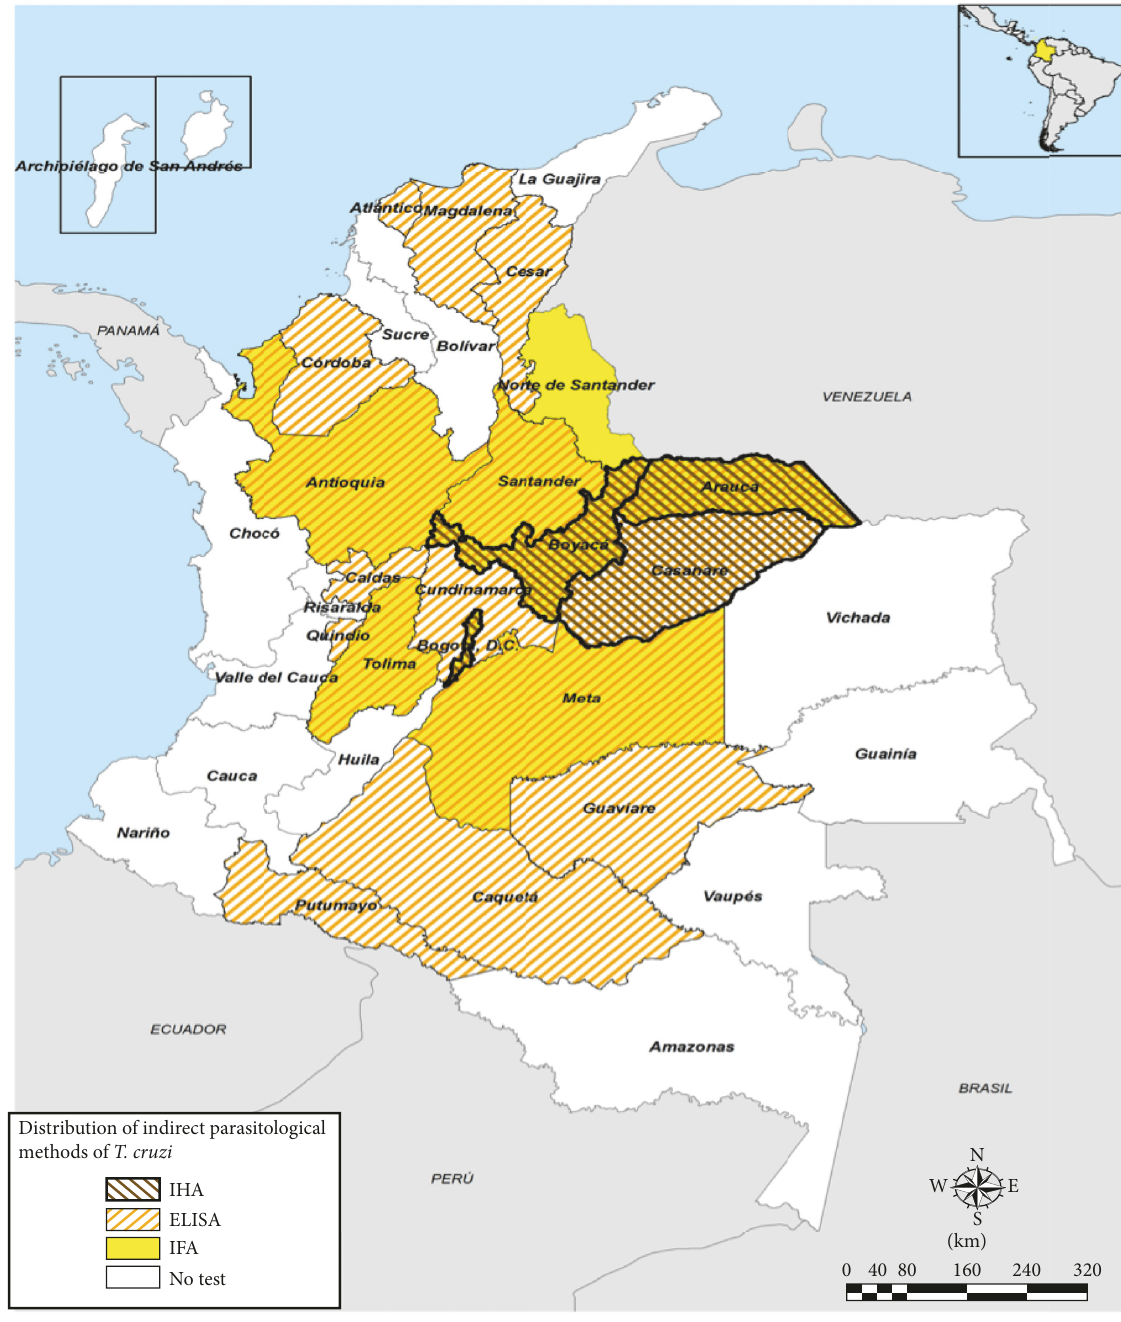
Figure 3: Distribution of laboratories according to department with the capacity to perform indirect parasitological tests (ELISA, IFA, and IHA) for diagnosis of Chagas disease in